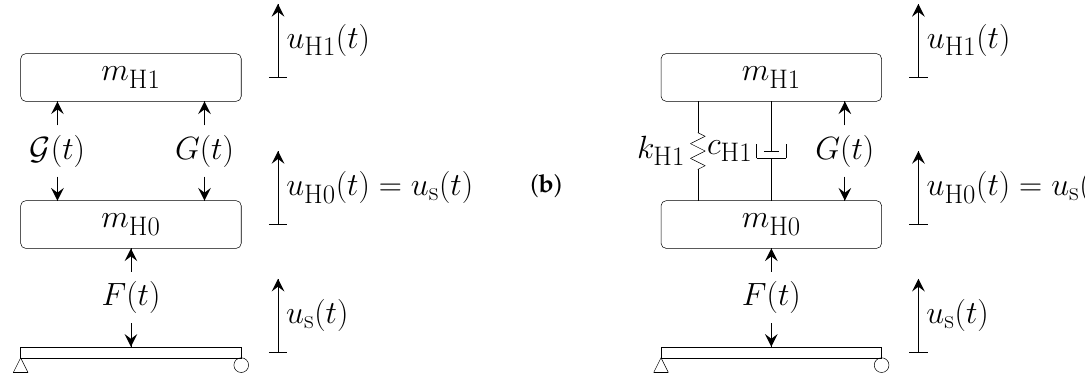
Figure 1. Schematic representation of the human body dynamics modeled by a non-driven ( m H0 ) and a driven mass ( m H1 ). Connection with the supporting surface modeled ( a ) generically and ( b ) by a spring and viscous